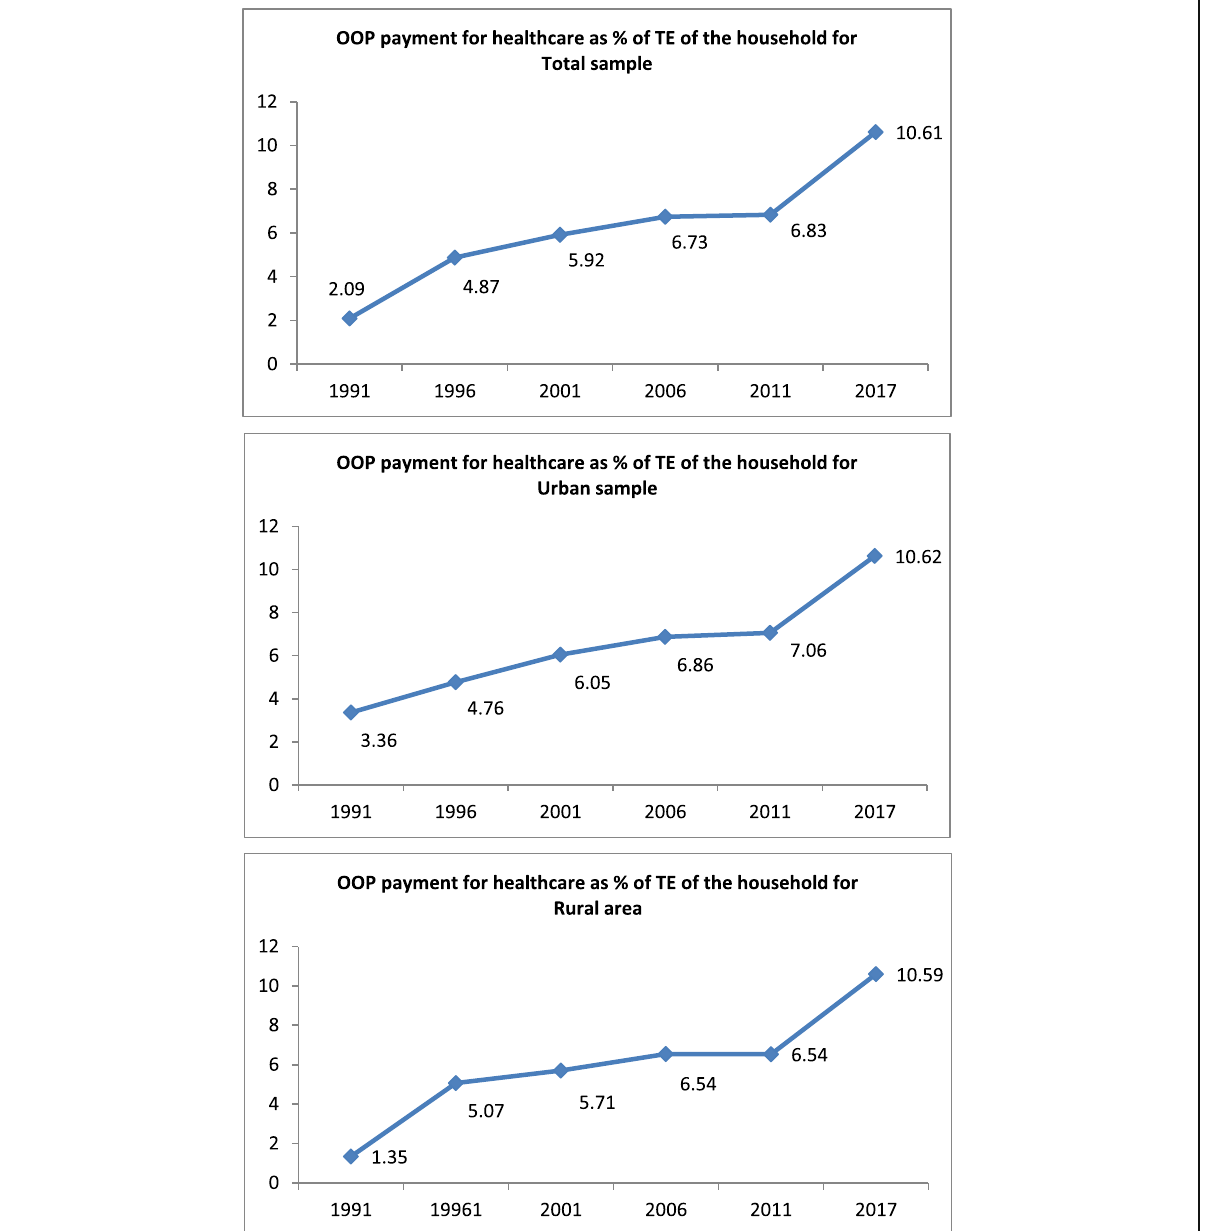
Fig. 1 Trend in OOP payment for healthcare services as percentage of the households ’ CTP for the total, urban, and rural households over